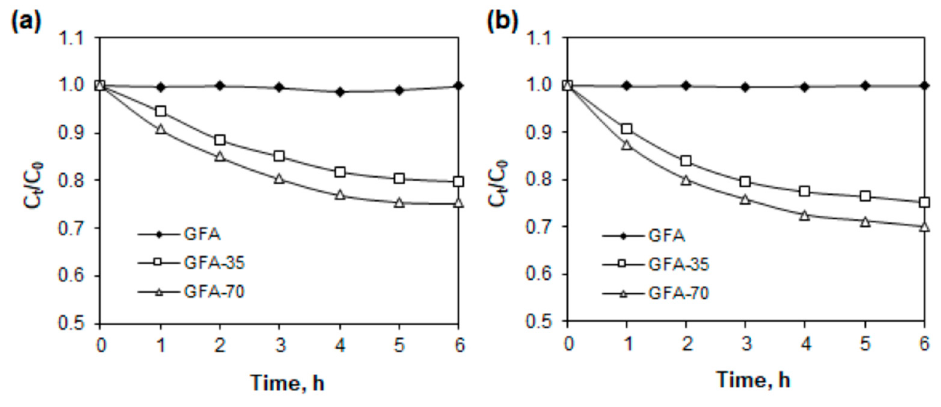
Figure 10. Oxidation of 4-chlorophenol with hydrogen peroxide in the presence of (a) GFA materials from water, (b) 0.05 mol L − 1 sodium sulfate solution.